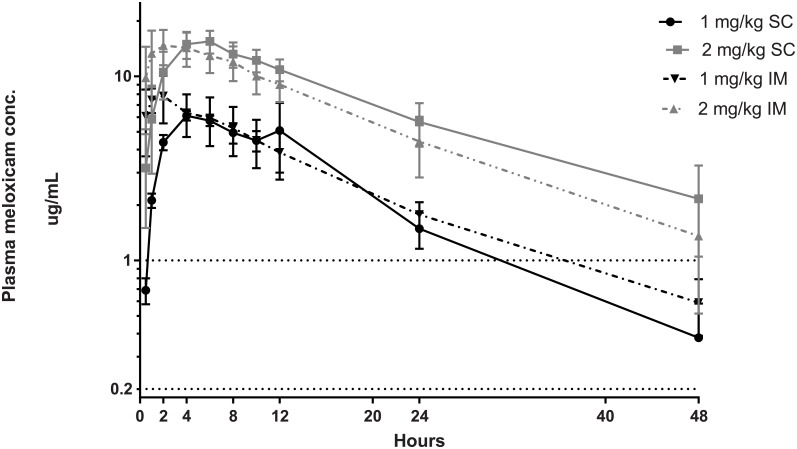
Semi log representation of plasma meloxicam concentration over time of all treatments.Dotted line at 0.2 ug/mL is meloxicam plasma concentration associated with the half maximal effective concentration (EC50) that provides pain relief in horses with experimentally induced arthritis [6]. Dotted line at 1 ug/mL approximates effective plasma concentrations to ameliorate inflammation suggested for humans, dogs and horses: 0.13–0.2 [10], 0.82 [21] and 0.57–0.93 μg/mL [22], respectively.